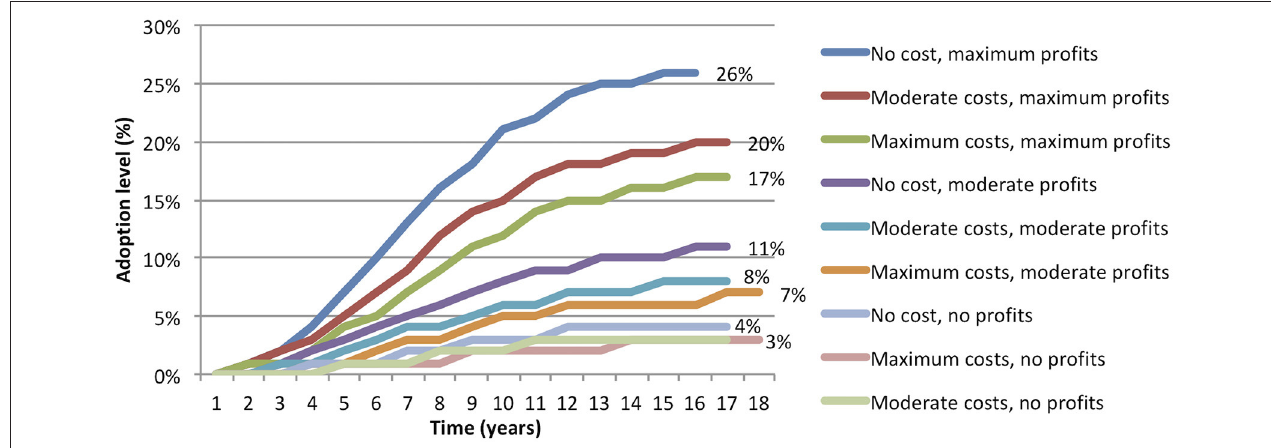
FIGURE 1 | Adoption curves of the predicted peak level and time to peak adoption levels for the nine cost-profit